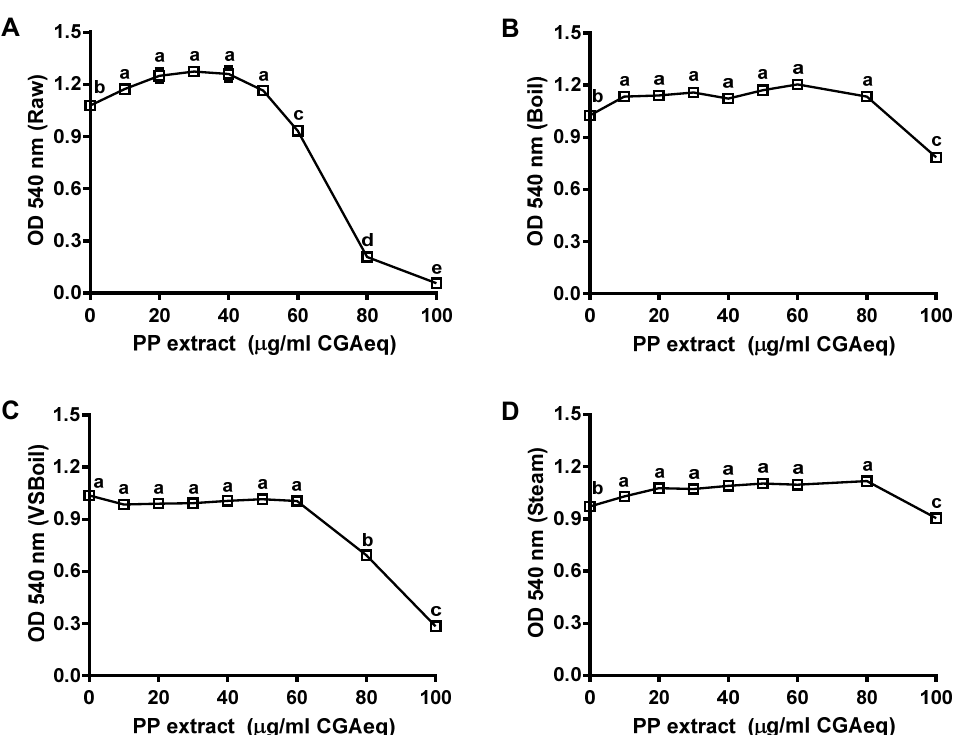
Figure 3. The cell viability of Caco-2 cell treated with raw and cooked purple potato (PP) extract. ( A ) Raw PP extract; ( B ) Boil; ( C ) VSBoil (vacuum-seal boiling); ( D ) Steam. a–e means among bars without common letters differ significantly at p < 0.05 (mean ± SEM, n = 6).